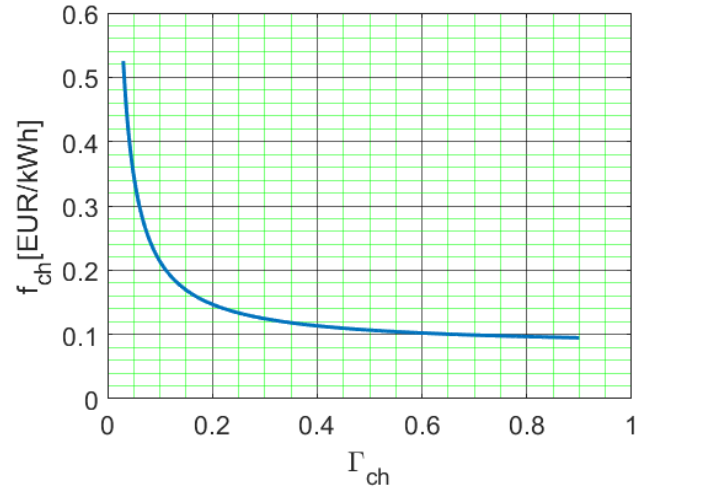
Figure 6. The normalised cost f ch as a function of Γ ch